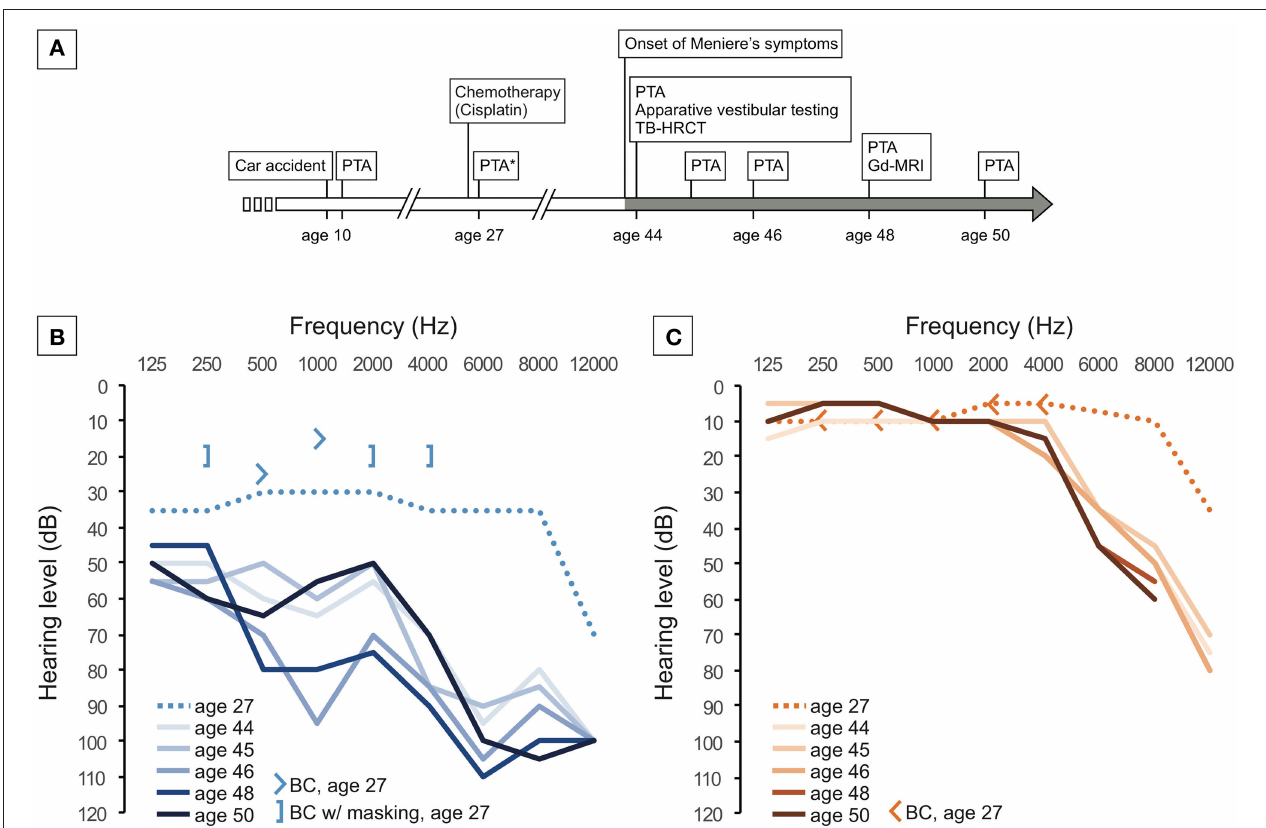
FIGURE 1 | (A) Timeline of the patient’s medical history and of diagnostic interventions. (B,C) Repeated pure-tone audiometric recordings for the left ear (B) and right ear (C) between age 27 and 50 years. Curves indicate air conduction thresholds. Arrows and brackets indicate bone conduction (BC) thresholds, as measured at age